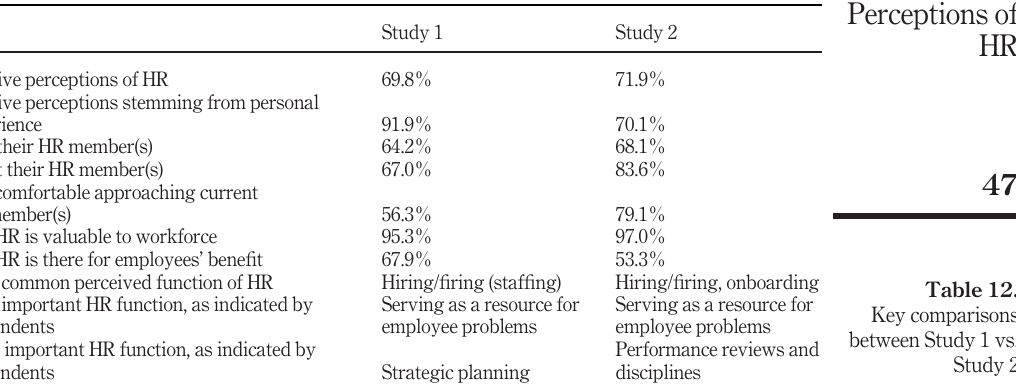
Table 12. Key comparisons between Study 1